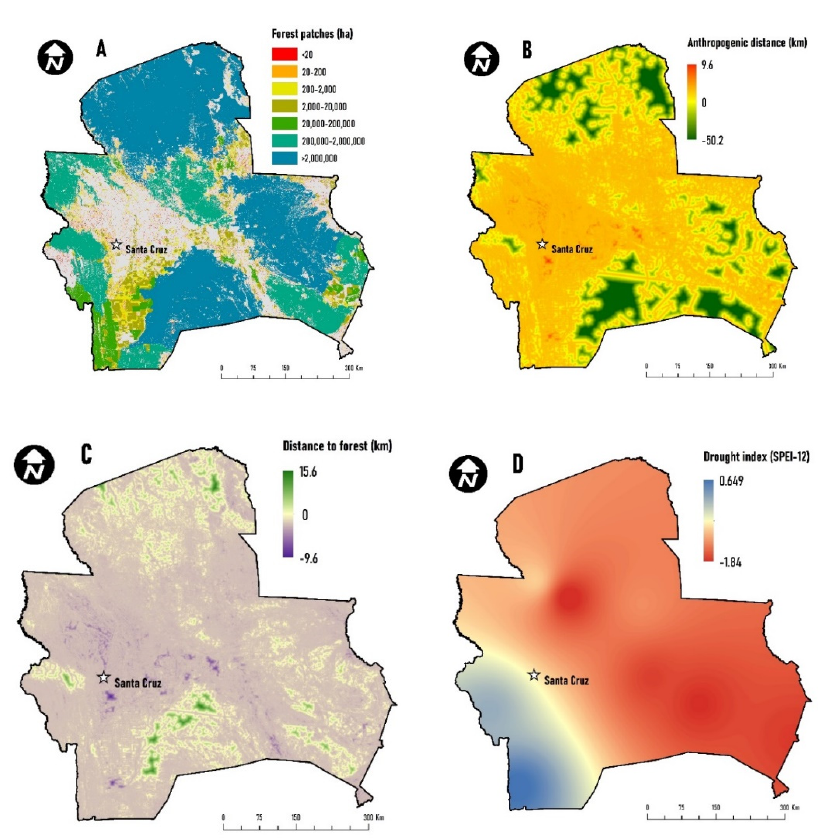
Figure 4. Variables used in the analysis to determine the relationship between fragmentation and burns in the year 2019, in the Department of Santa Cruz. ( A ) Categories of forest patch sizes, ( B ) Euclidean distance to anthropogenic areas, ( C ) Euclidean distance to forest areas and ( D ) average of the July to October 12-month standardized precipitation-evapotranspiration index